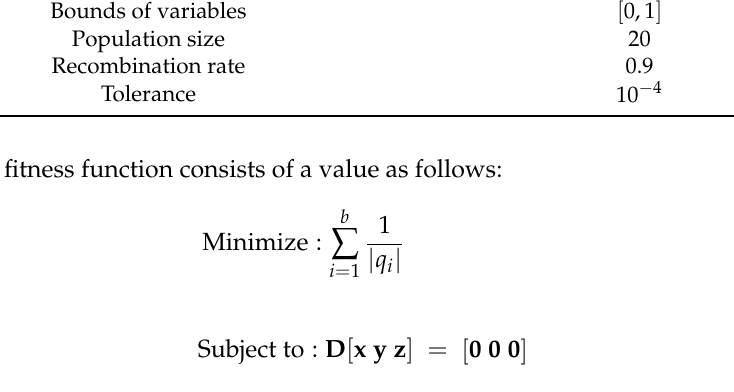
Table 3. Main parameters of DE algorithm. Parameter Value Bounds of